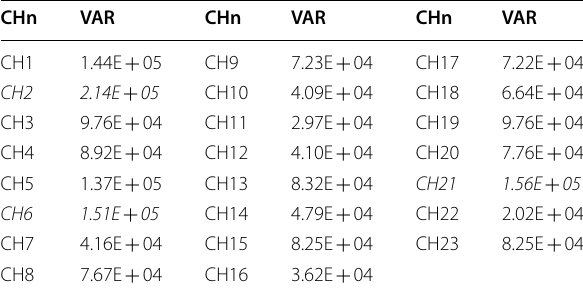
Table 1 Calculation of the variance for the 23 channels and channel selections